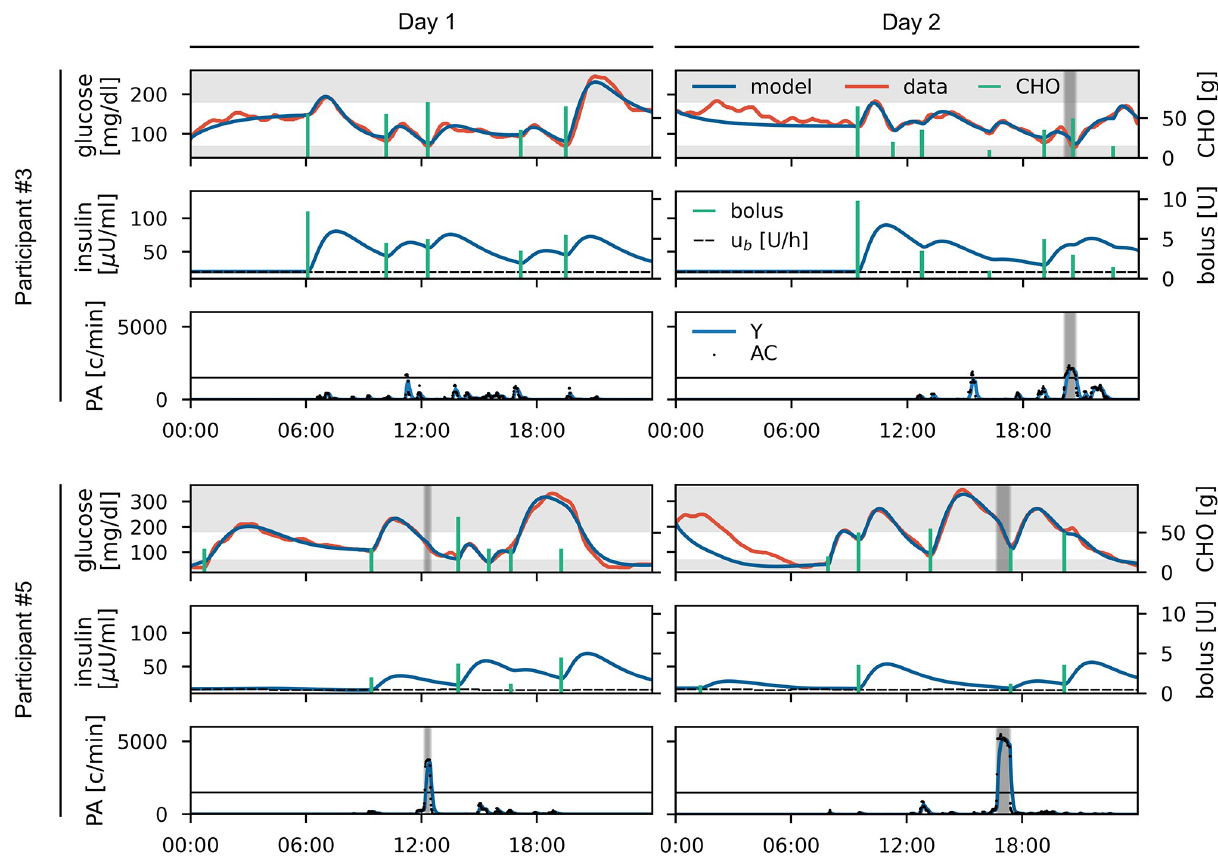
Fig 5. Data and personalized model for study participants #3 and #5 for two days each. For each day, recorded (red) and fitted (blue) glucose data and carbohydrate inputs (green) are shown in the upper panel. Modelled insulin concentration (blue) and insulin inputs (green) including the basal insulin infusion rate (dashed) are shown in the middle panel. Accelerometer counts (dotted) and modelled PA intensity Y (blue) are shown in the lower panel with periods of physical activity highlighted in grey. The remaining participants are shown in Fig H in S1